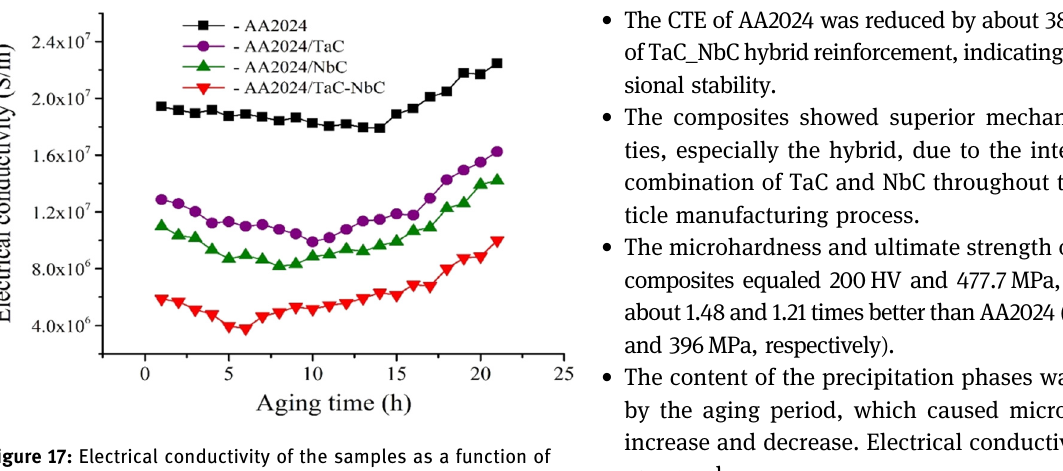
Figure 17: Electrical conductivity of the samples as a function of arti fi cial aging